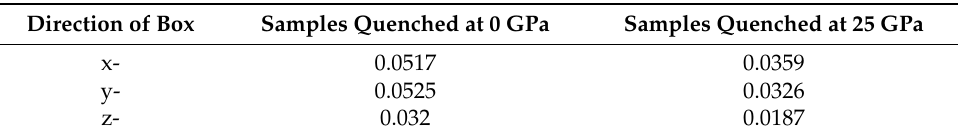
Table 1. The results of Chi-square test of the uniform distribution of the ‘fast’ atoms in the three directions of the box.